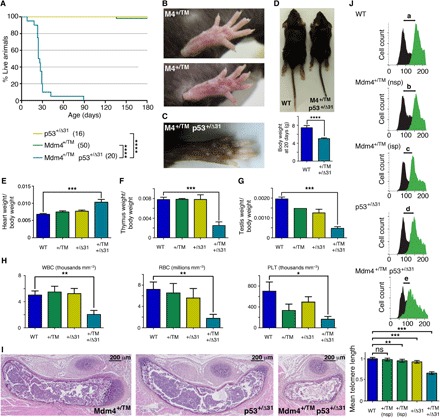
Mdm4+/TM mice are hypersensitive to increased p53 activity.(A) Impact of increased p53 activity on Mdm4+/TM animals. Cohort sizes are in parentheses. (B) Footpads from Mdm4+/TM mice appear normal (top) or exhibit a subtle increase in pigmentation (bottom). (C) Mdm4+/TM
p53+/Δ31 mice exhibit strong skin hyperpigmentation. (D) Mdm4+/TM
p53+/Δ31 mice are smaller than age-matched WT mice. (E to G) Mdm4+/TM
p53+/Δ31 mice exhibit heart hypertrophy (E) as well as thymic (F) and testicular (G) hypoplasia. (H) Mdm4+/TM
p53+/Δ31 mice exhibit abnormal hemograms. Counts for white blood cells, red blood cells, and platelets for five age-matched (P18) animals per genotype are shown. (I) Hematoxylin and eosin staining of sternum sections from mice of the indicated genotypes. (J) Flow-FISH analysis of P18 bone marrow cells with a telomere-specific PNA probe. Top: Representative results for a WT, a Mdm4+/TM with normal skin pigmentation (nsp), a Mdm4+/TM with increased footpad skin pigmentation (isp), a p53+/Δ31, and a Mdm4+/TM
p53+/Δ31 mouse are shown; black histograms, cells without the probe; green histograms, cells with the probe. The smallest shift in fluorescence intensity (e) was observed with Mdm4+/TM
p53+/Δ31 cells. Bottom: Statistical analysis of green fluorescence shifts. Means + 95% CI are shown; data are from >1500 cells per genotype. In relevant panels: ns, not significant; *P < 0.05, **P < 0.01, ***P < 0.001, and ****P < 0.0001 by Mantel-Cox (A), Student’s t (D and E to H), or Mann-Whitney (J) statistical tests. Photo credits: R.D. and P.L., Institut Curie (B); E.T. and R.D., Institut Curie (C and D).